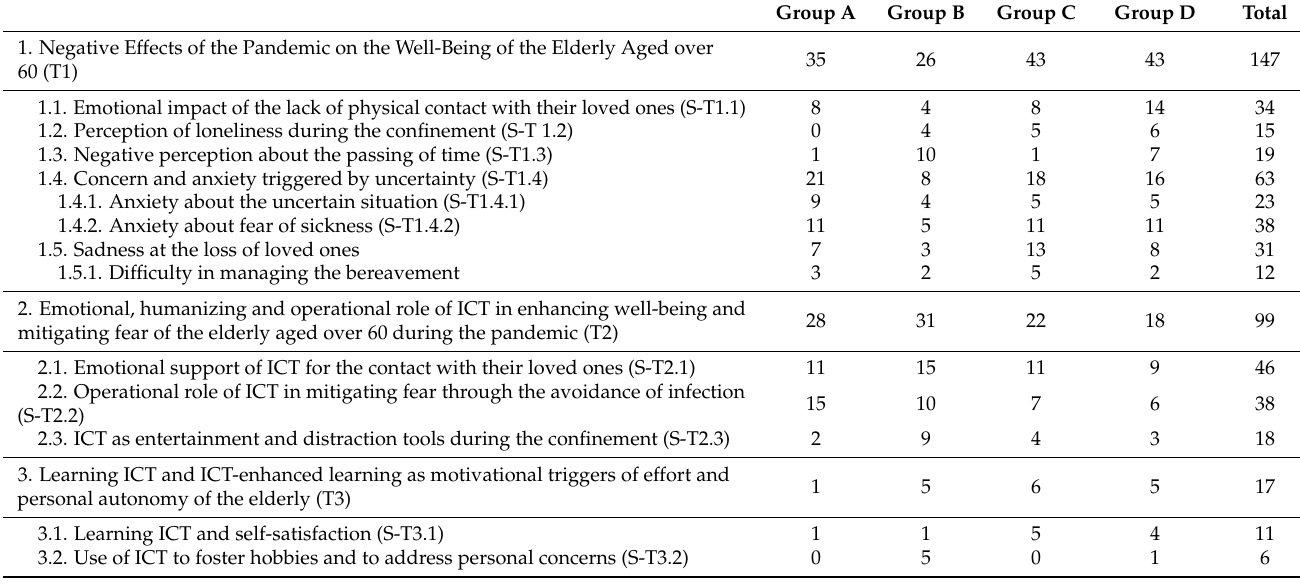
Table 2. Absolute occurrences or frequencies of the themes and sub-themes within the discourses of the four focus groups ( n = 27).